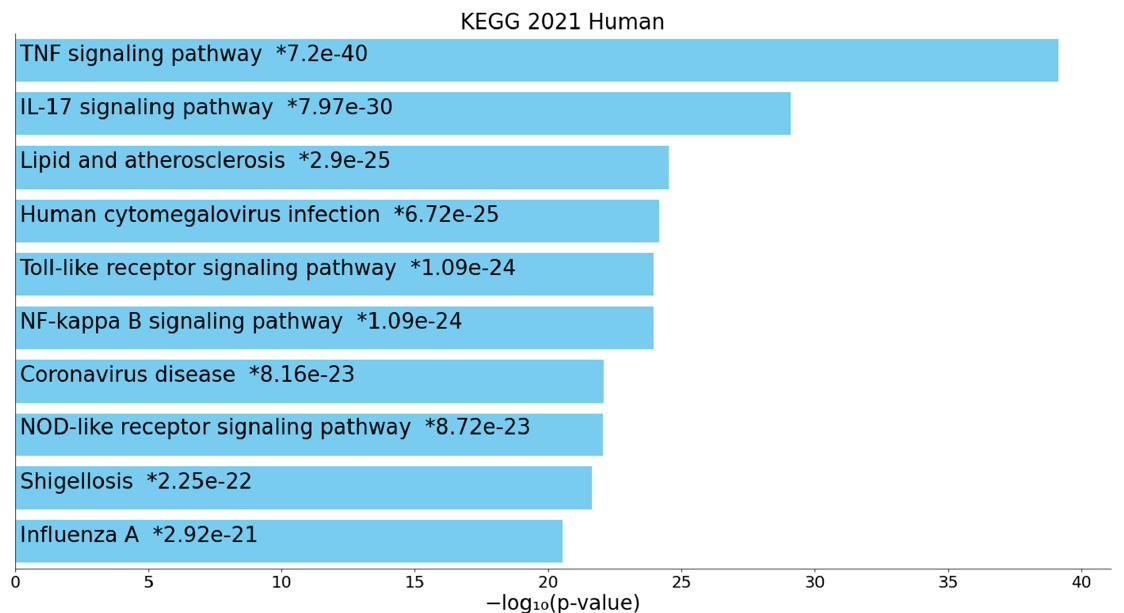
Figure 3. Heatmap of enriched KEGG (Kyoto Encyclopedia of Genes and Genomes) terms showing the top 10 functions that were overexpressed in the first protein subnetwork of patients who died due to ischemic stroke (accumulative hypergeometric p -values). TNF: tumor necrosis factor; IL: interleukin; NF-kappa B: nuclear factor kappa B; NOD: nucleotide- binding, and oligomerization domain. “Colored bars correspond to terms with significant p -values (<0.05); the * indicate that the term has a significant adjusted p -value (<0.05)” (Appyters, Appyter (maayanlab.cloud) as accessed on 6 November 2021).